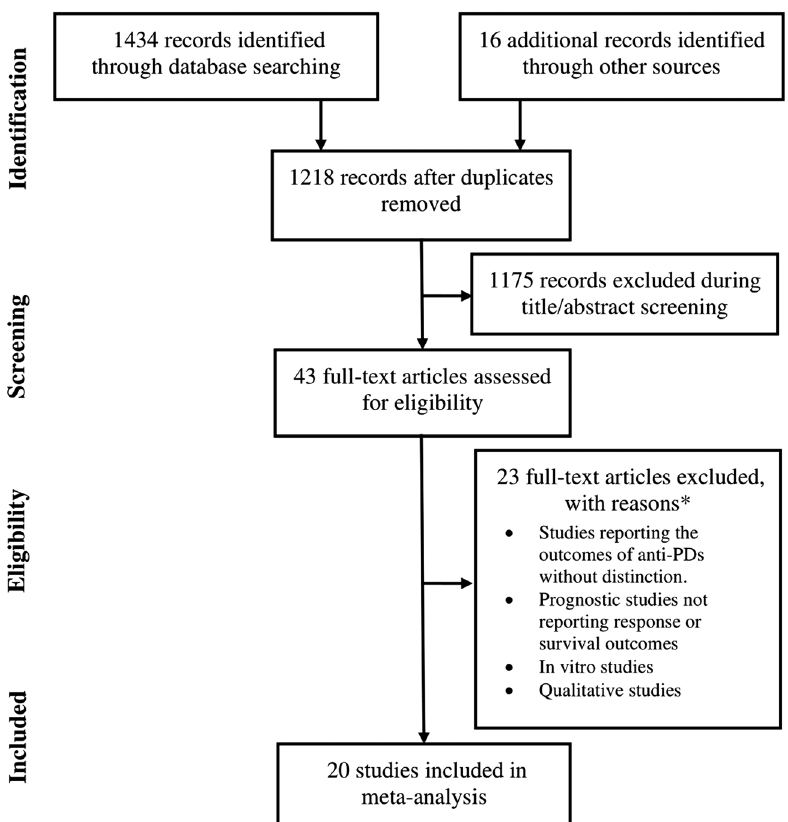
Figure 1: A fl owchart of study screening and selection